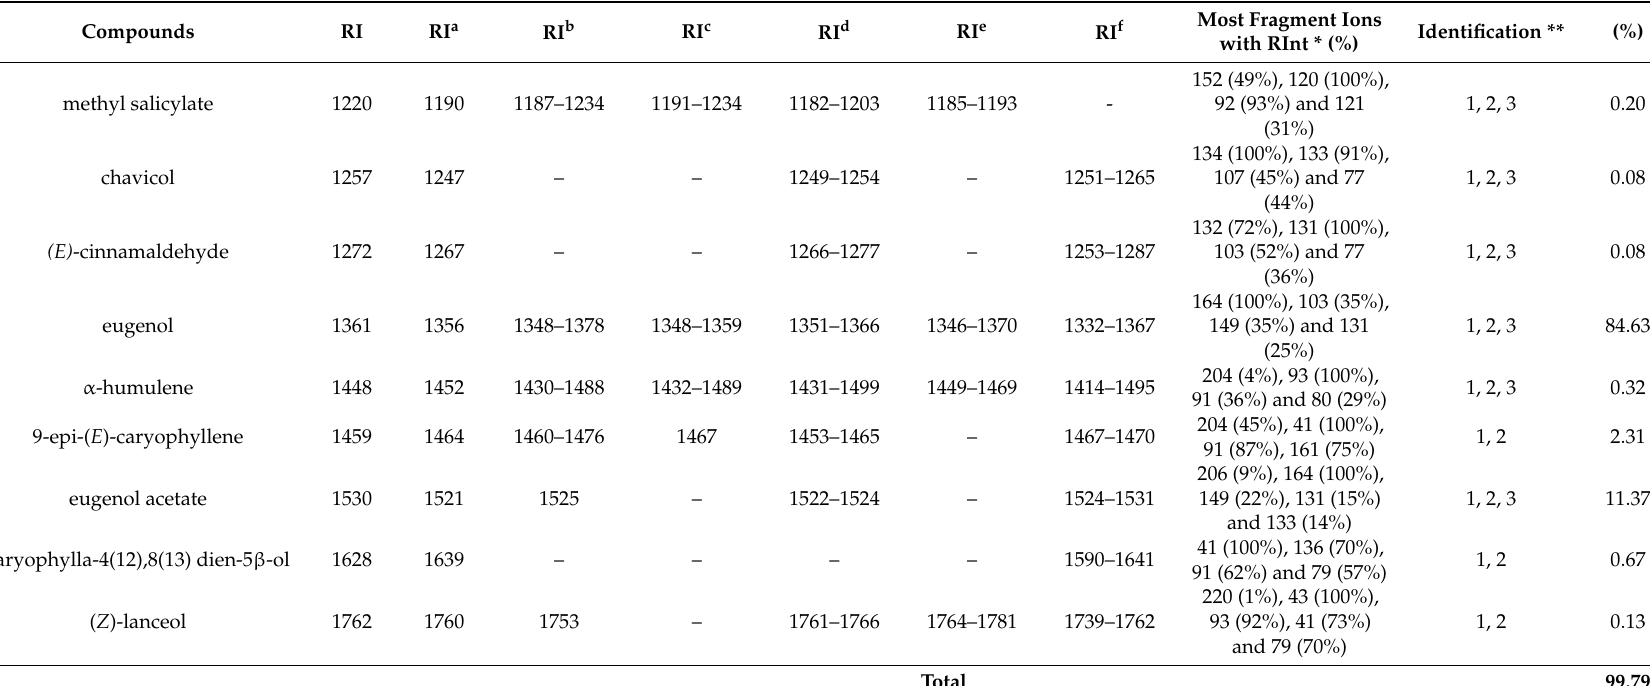
Table 1. Compounds identified in the essential oil of S. aromaticum using gas chromatography mass spectrometry (GC-MS).